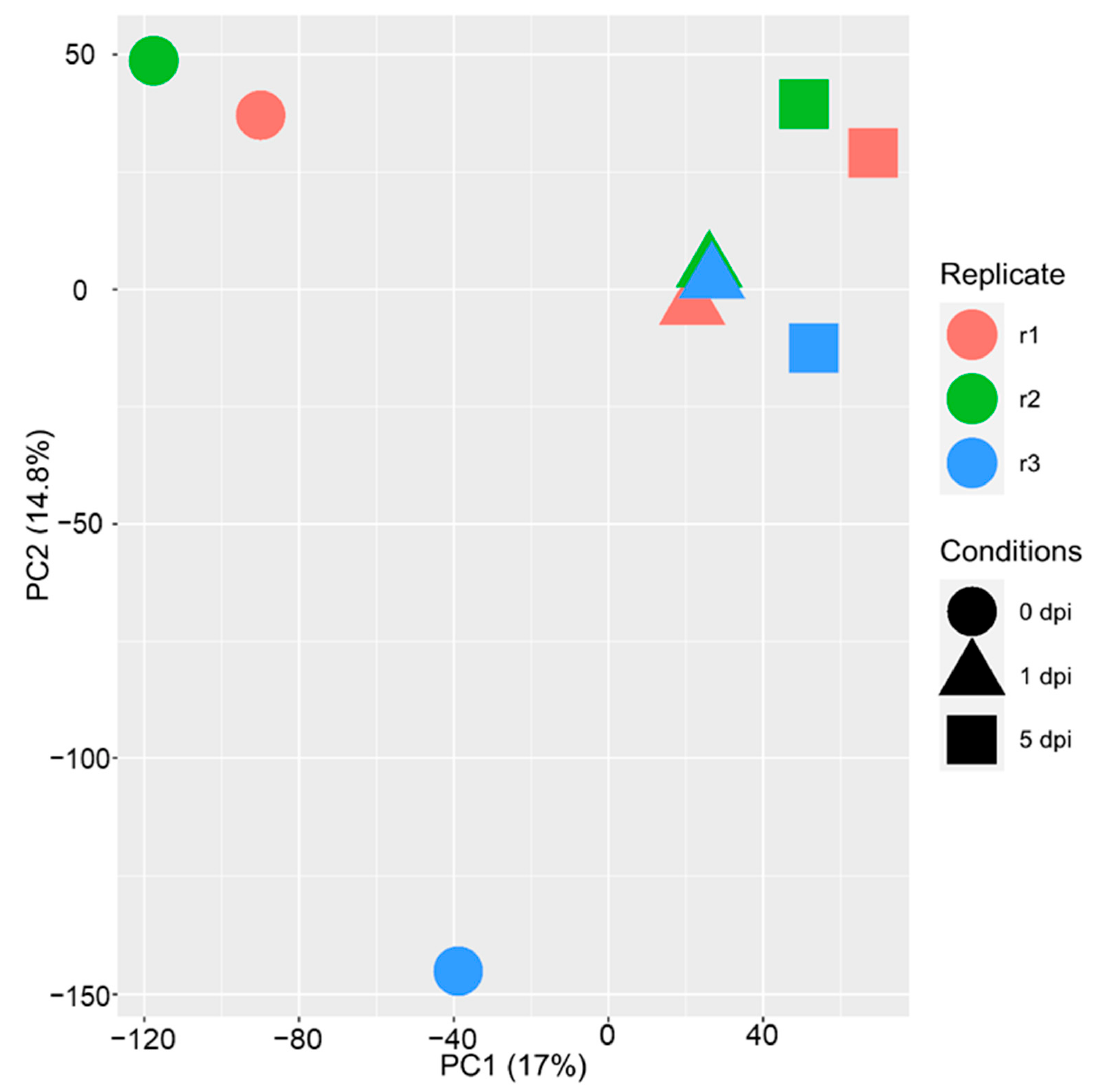
Figure 7. Principal component analysis (PCA) of the 19,358 genes expressed in WCR. Conditions are represented with colors (replicate 1: red, replicate 2: green and replicate 3: blue) and shapes (circle: 0 dpi, triangle: 1 dpi and square: 5 dpi).